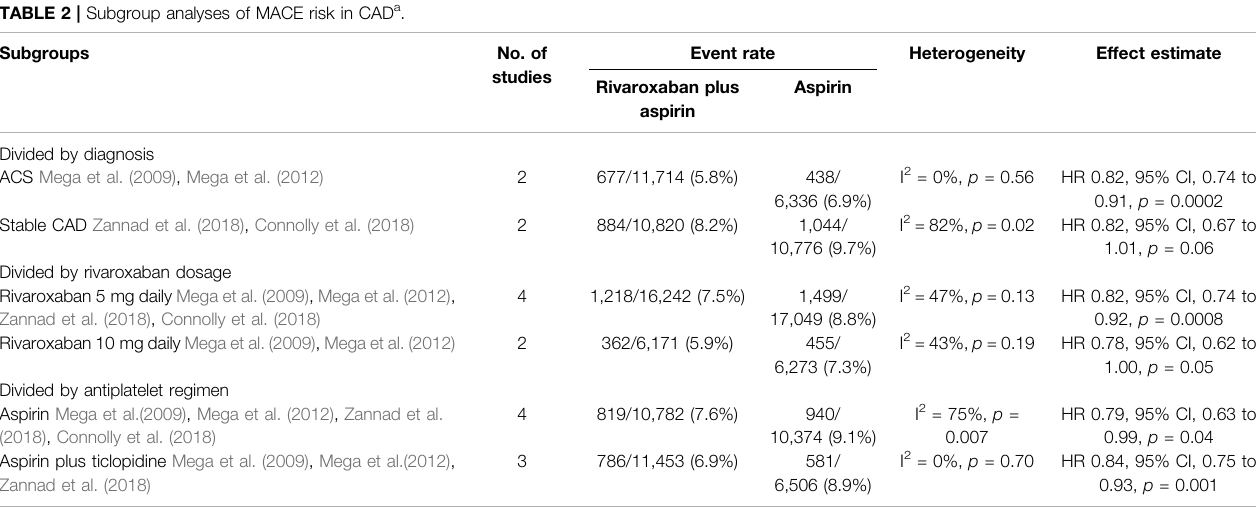
TABLE 2 | Subgroup analyses of MACE risk in CAD a .